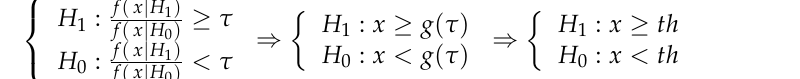
styles of lines with colors that are closed to Red color to represent “Locating Accurately”, and different